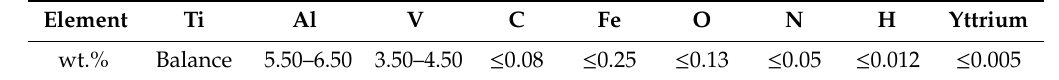
Table 1. Chemical composition (wt.%) of used Ti-6Al-4V.